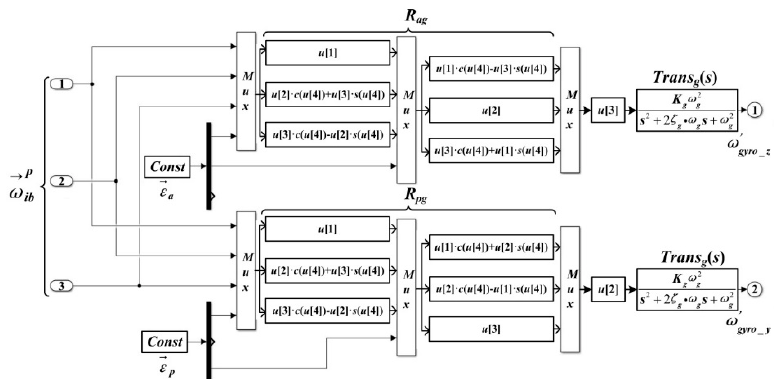
Figure 13. Simulation module of the signals and assembly errors of the gyroscopes.